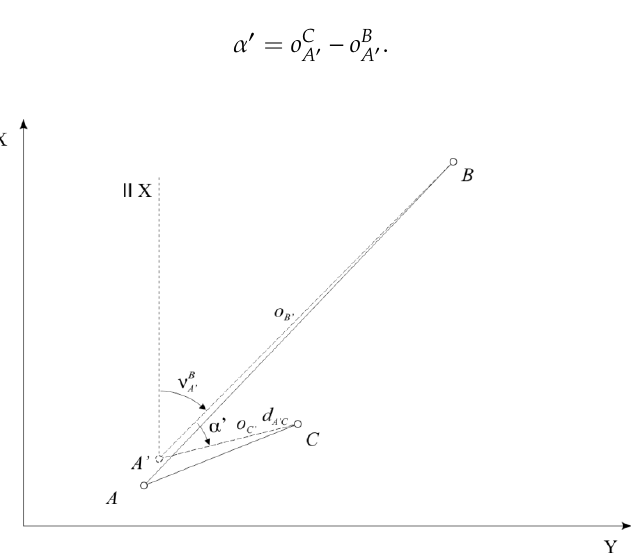
Figure 6. Displacement at survey point 𝐴 : geometry.